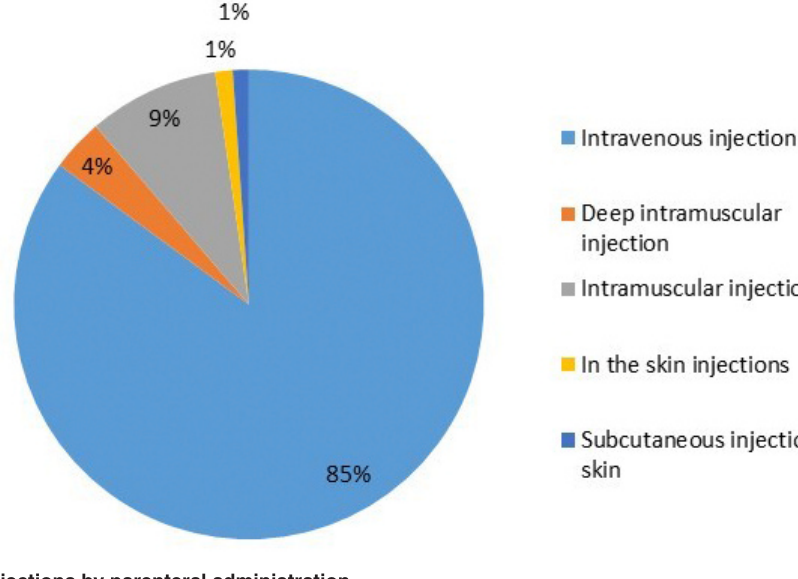
Figure 1. Number of injections by parenteral administration.